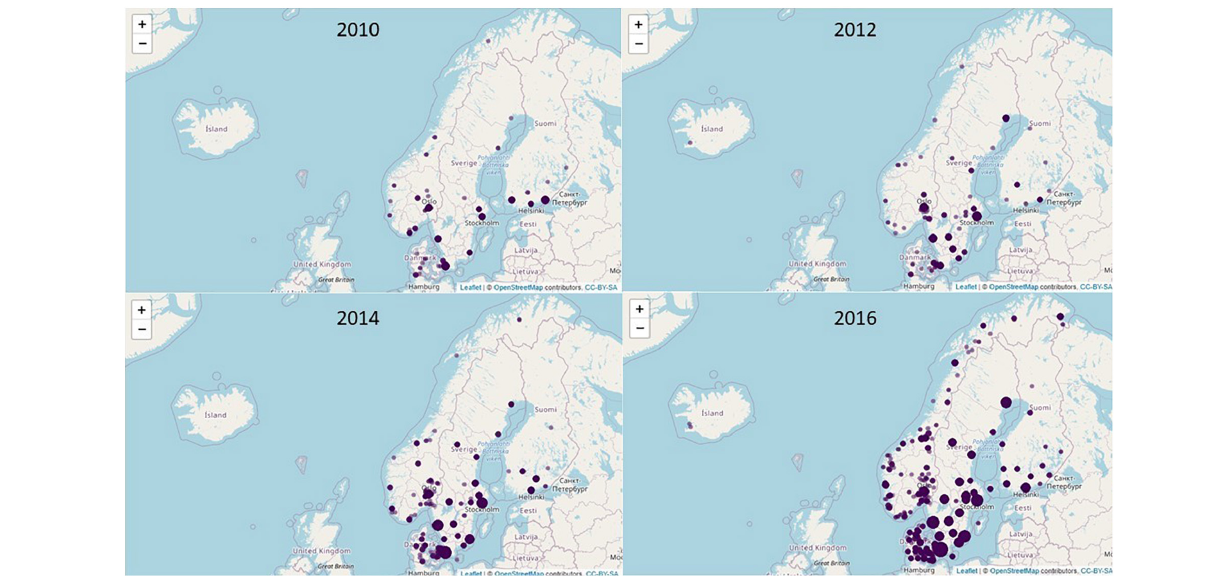
FIGURE 2 | Geographic distribution of MRSA spa -type t223 in the Nordic countries in the years.2010, 2012, 2014, and